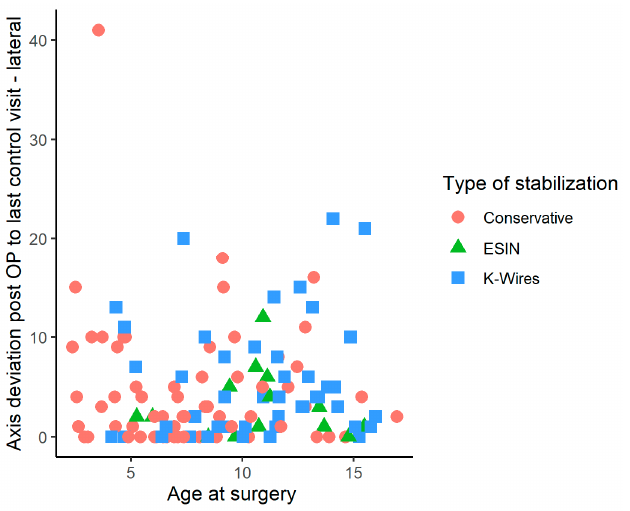
Figure 3. Change of axis deviation in lateral plane X-ray images obtained immediately after surgery, compared to axis deviations observed at the last follow-up, by age at surgery and the three types of